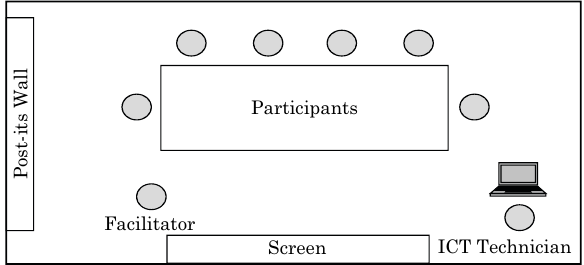
Fig. 3. Layout of the decision conferencing room (Adapted from Bana e Costa et al. 2014: